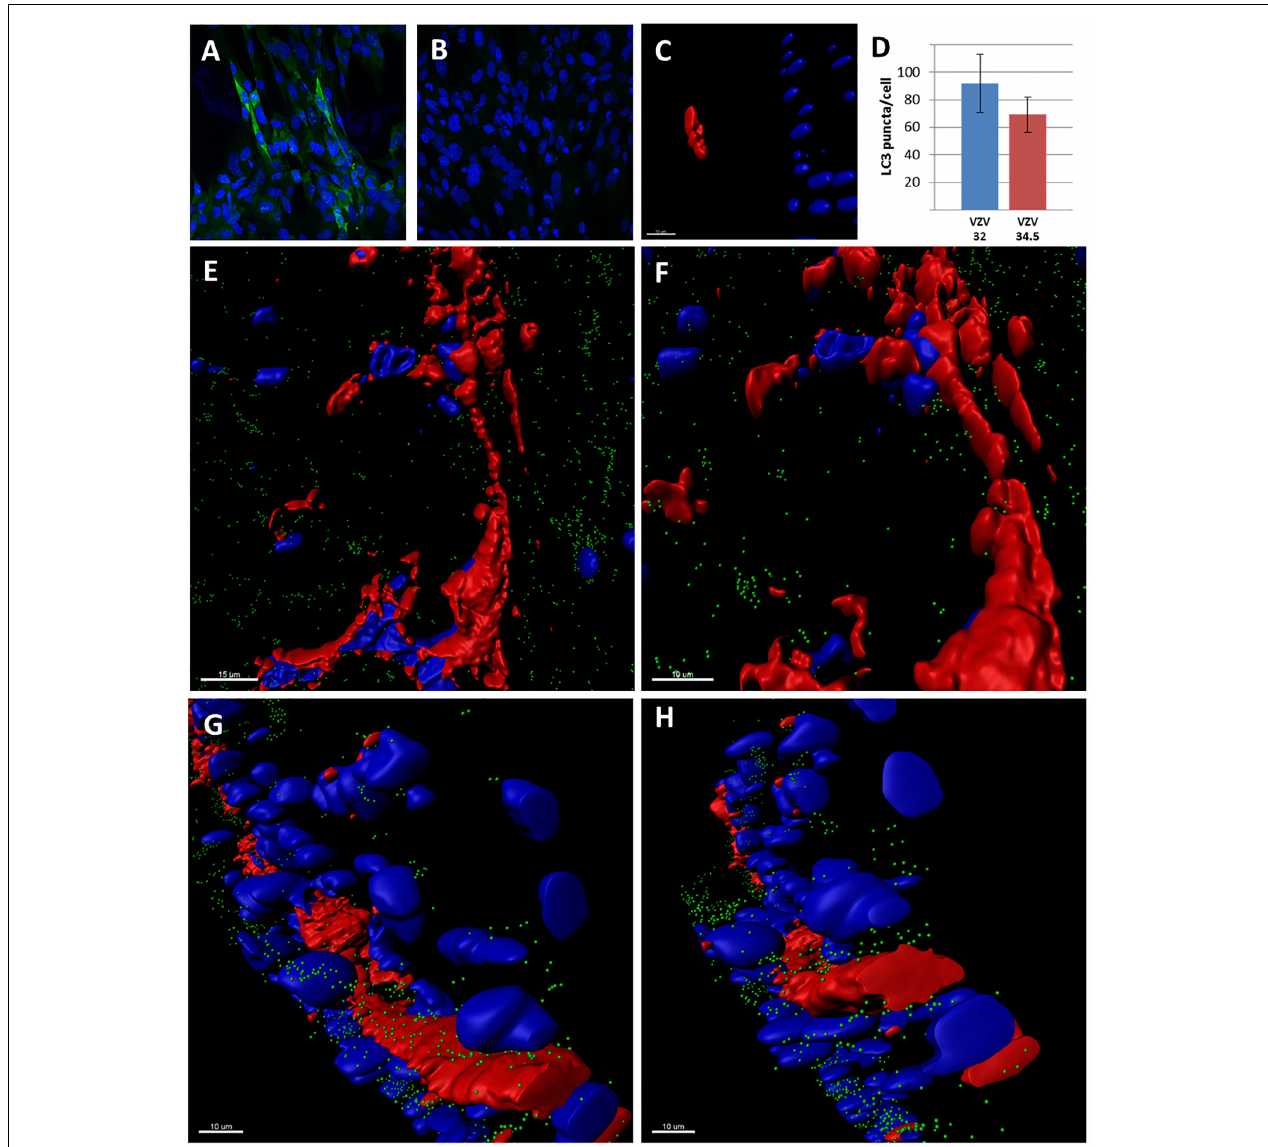
FIGURE 5 | Studies with the recombinant VZV/34.5 virus. (A) Immunolabeling of the HSV1 ICP34.5 protein after infection with rVZV/34.5. The ICP34.5 protein is labeled green. (B) Control immunolabeling with the anti-ICP34.5 antibody in wild-type VZV infection. No ICP34.5 protein was detected. (C) Small focus of VZV/34.5 infection in SOC at 14 dpi. Larger infectious foci were first seen at 28 dpi. (D) Graph of autophagosome counts for VZV-32 and VZV/34.5 strains in SOC at 28 dpi. Six individual sections were examined. There was no statistical difference. (E–H) Imaris renderings of confocal micrographs in SOC infected with VZV/34.5 for 28 days. VZV-induced syncytia were apparent in each panel because VZV gE immunolabeling was detectable around multiple nuclei without evidence of any barriers by individual cellular membranes. VZV glycoprotein gE is labeled red; autophagic puncta are labeled green; nuclei are labeled